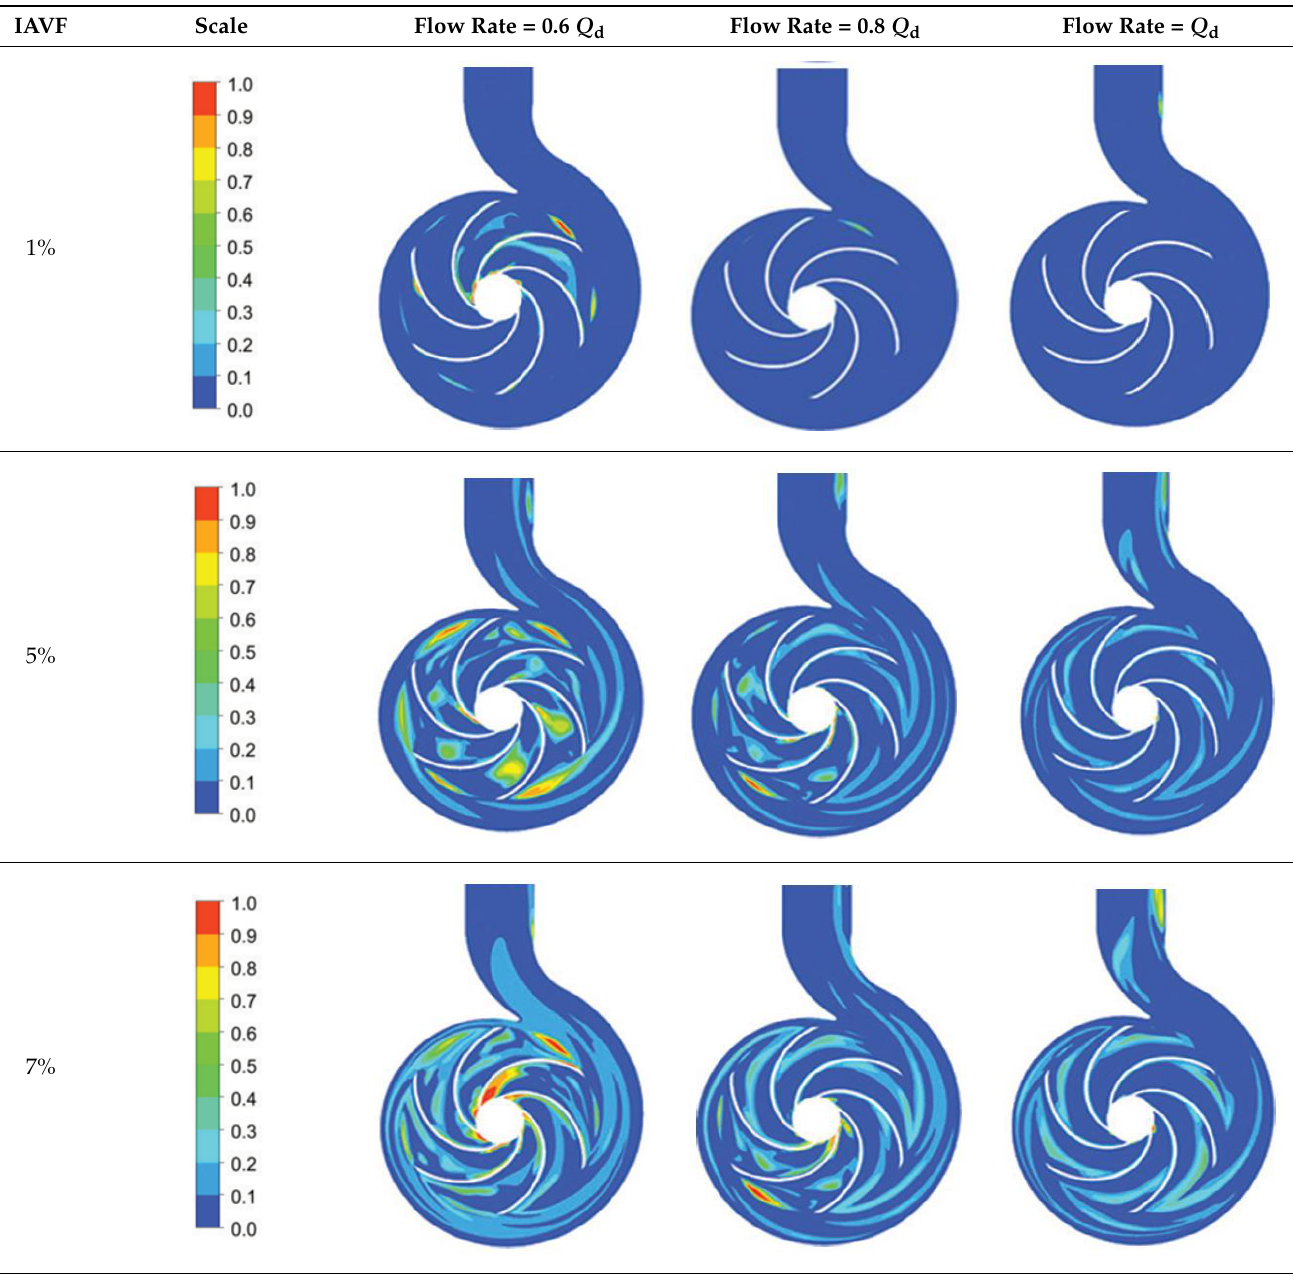
Table 7. Gas distribution in centrifugal pump impeller flow channel at various flow rates and IAVFs [28]. IAVF Scale